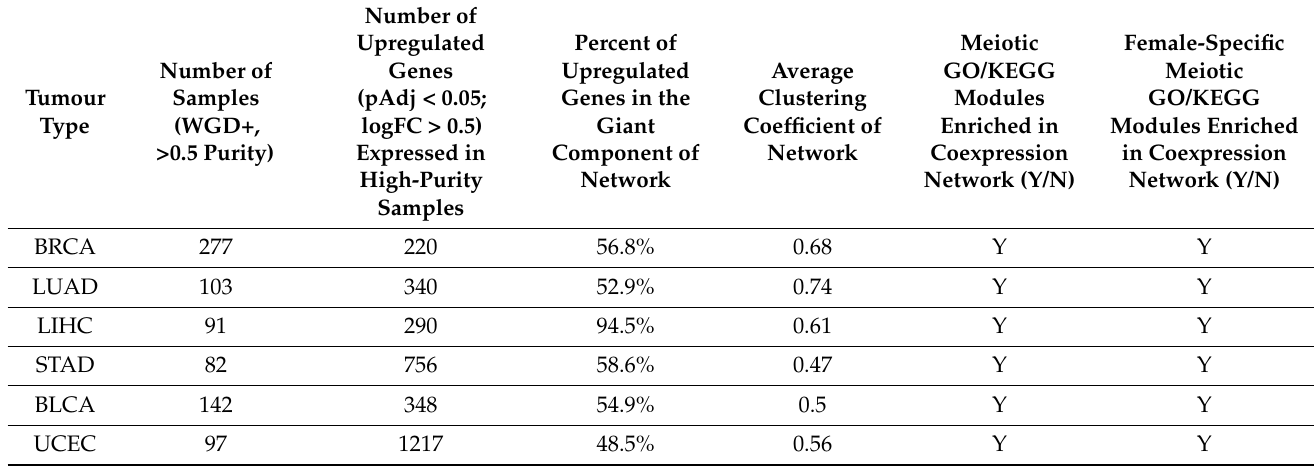
Table 2. Parameters of the ploidy-upregulated genes, the coexpression network thereof,